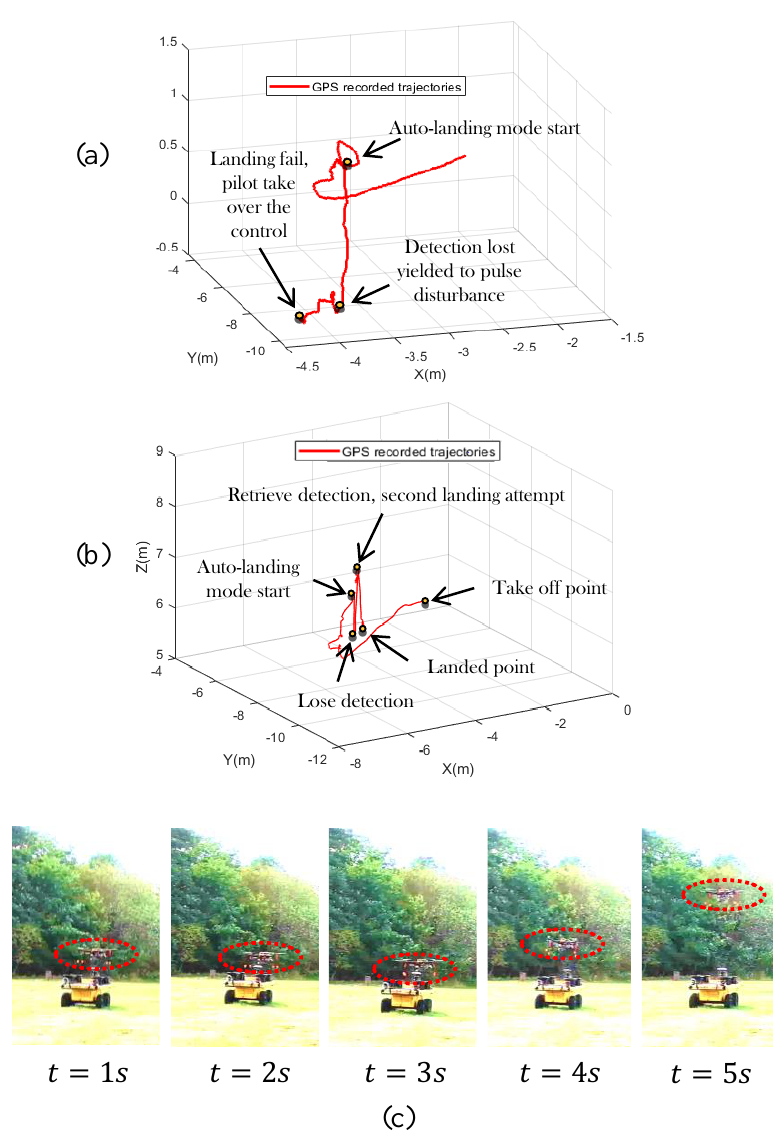
Figure 11. Comparison of the UAV landing in extreme scenarios with and without the integrated safety strategy ( a ) Raw GPS flight data of UAV landing without safety strategy subject to a wind gust; ( b ) Raw GPS flight data of UAV landing encounters strong wind gusts with integrated safety strategy; ( c ) UAV vision retrieve action: wind gust emerges at t = 1 s, UAV is blown away and loses tag detection at t = 3 s, then t = 4 s ∼ 5 s, the drone increases thrust to retrieve the tag detection and perform the landing